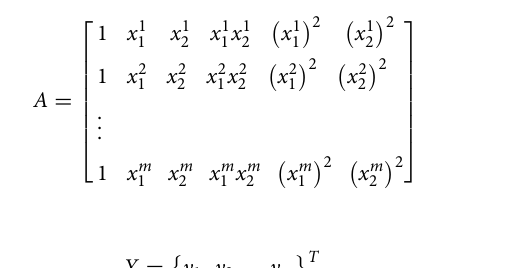
where N is the number of data, y p is the predicted output of neurons in each layer, and y m is the observed value. In the GMDH structure, contrary to conventional matrix structure, a number of mathematical equations are applied to speed up calculation process 44 . The output of each neuron is calculated according to Volterra–Kol- mogorov–Gabor (VKG) polynomial. The second-order polynomial is incorporated in the structure of GMDH 43 and is used in this study as the transfer functions in each neuron. The second-order polynomial may be written in the following form: